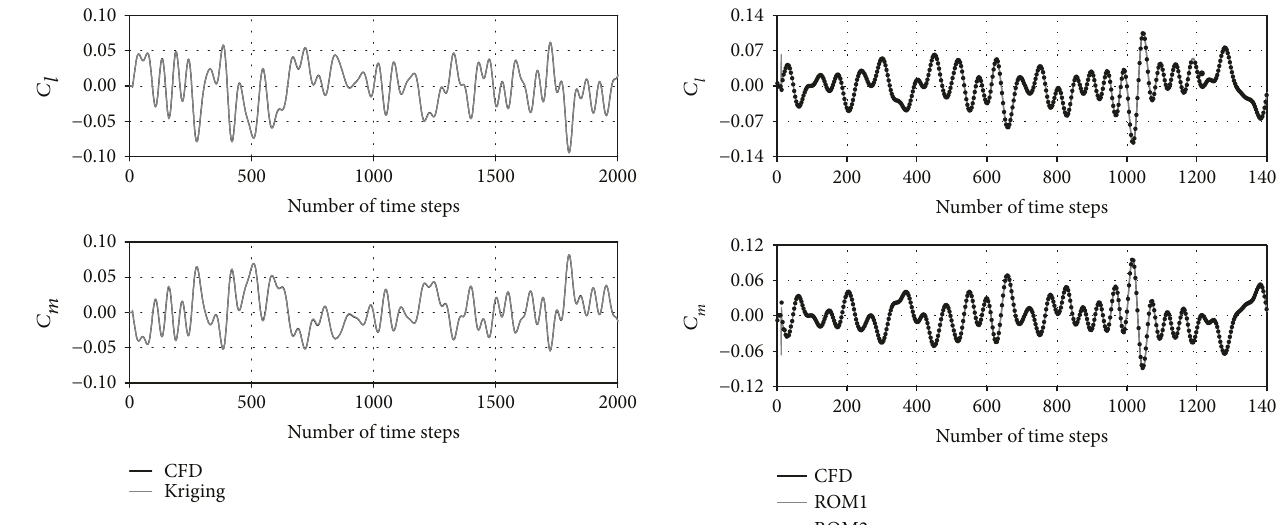
Figure 8: The training data validation of a NACA 64A010 airfoil at M α = 4 deg . ∞ = 0 82 and 0 Table 1: The computational cost associated with the time- dependent surrogate approach.